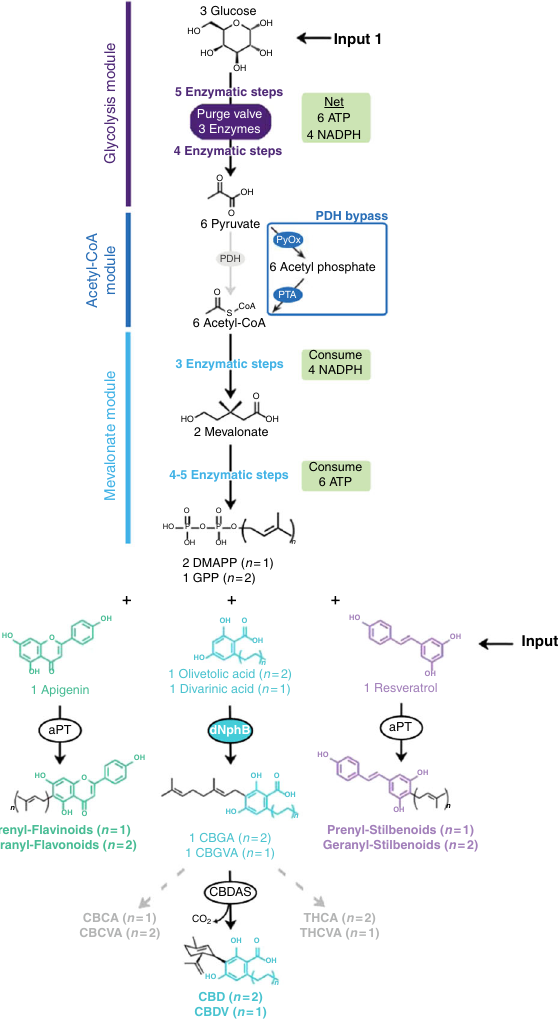
Fig. 1 The synthetic biochemistry platform for the production of prenyl- natural products. First, glucose is broken down into pyruvate through a glycolysis pathway modi fi ed to regulate NADPH levels (22) (12 enzymatic steps). Then, either PDH or the PDH bypass converts pyruvate into acetyl- CoA. Acetyl-CoA is converted into GPP via the mevalonate pathway (eight enzymatic steps). By varying the aromatic prenyltransferase (aPT)